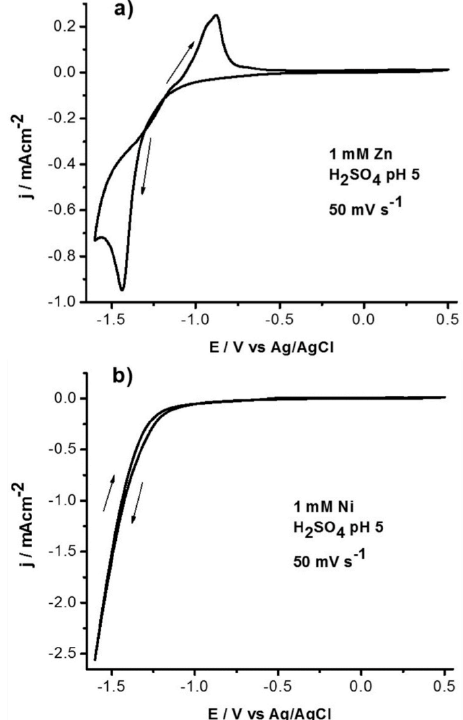
Figure 5. Cyclic voltammetries in: ( a ) 1 mM Zn and ( b ) 1 mM Ni, in H 2 SO 4 solutions. Scan rate 50 mV·s −1 .